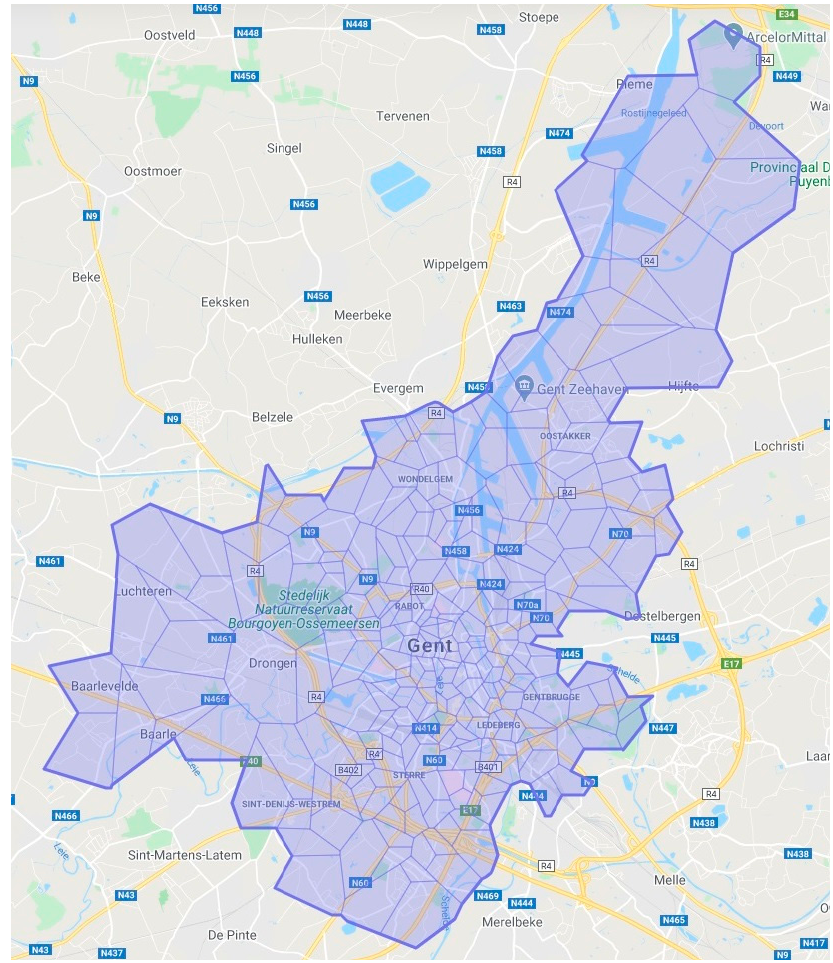
Figure 1. The mobile phone grid used by Proximus over the study area.